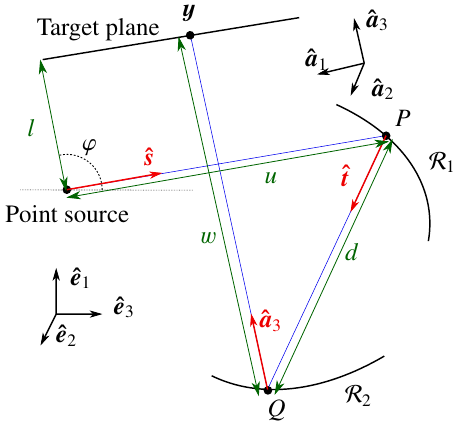
Figure 1: A cross-section of the optical system in the x , z -